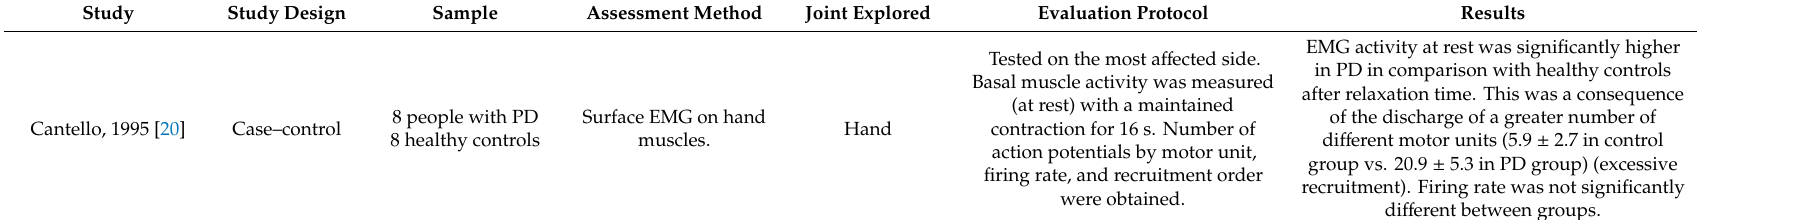
Table 2. Methods evaluating the mechanical or neurophysiological properties of the